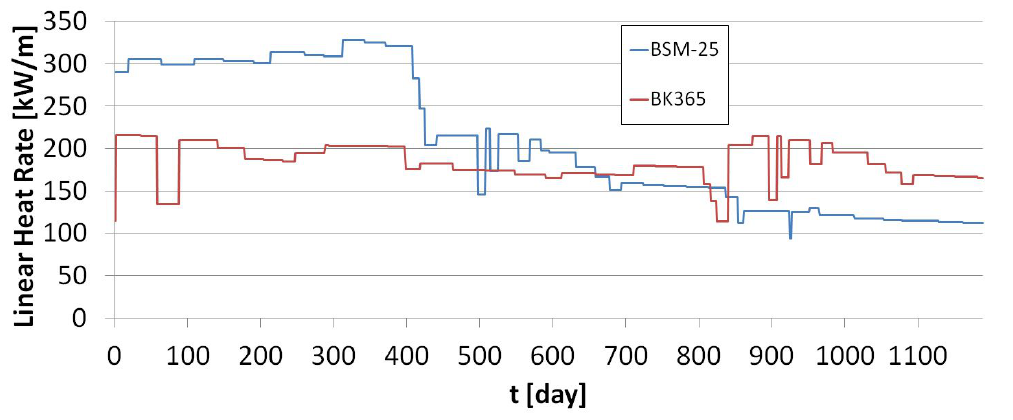
Figure 6. Power history of rods BSM-25 and BK365.